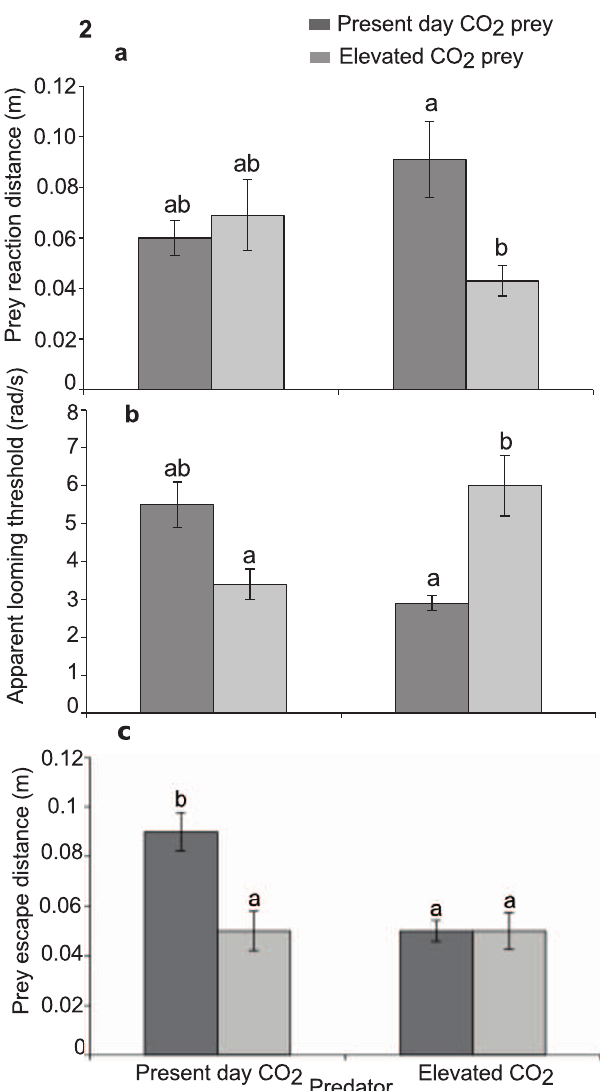
Figure 2. Effects of elevated CO 2 on prey escape performance. Comparison of the effects of elevated CO 2 (440, 880 m atm) on interactions between a predator ( Pseudochromis fuscus ) and prey ( Pomacentrus amboinensis ) on 3 performance variables of the prey: (a) prey reaction distance (b) apparent looming threshold (ALT) and (c) prey escape distance. (a) n=19, 14, 11, 19 (b) N=17, 14, 11, 16 and (c) N=17, 14, 11, 18 (left to right). Errors are standard errors. Letters above bars represent Tukey’s HSD groupings of means.